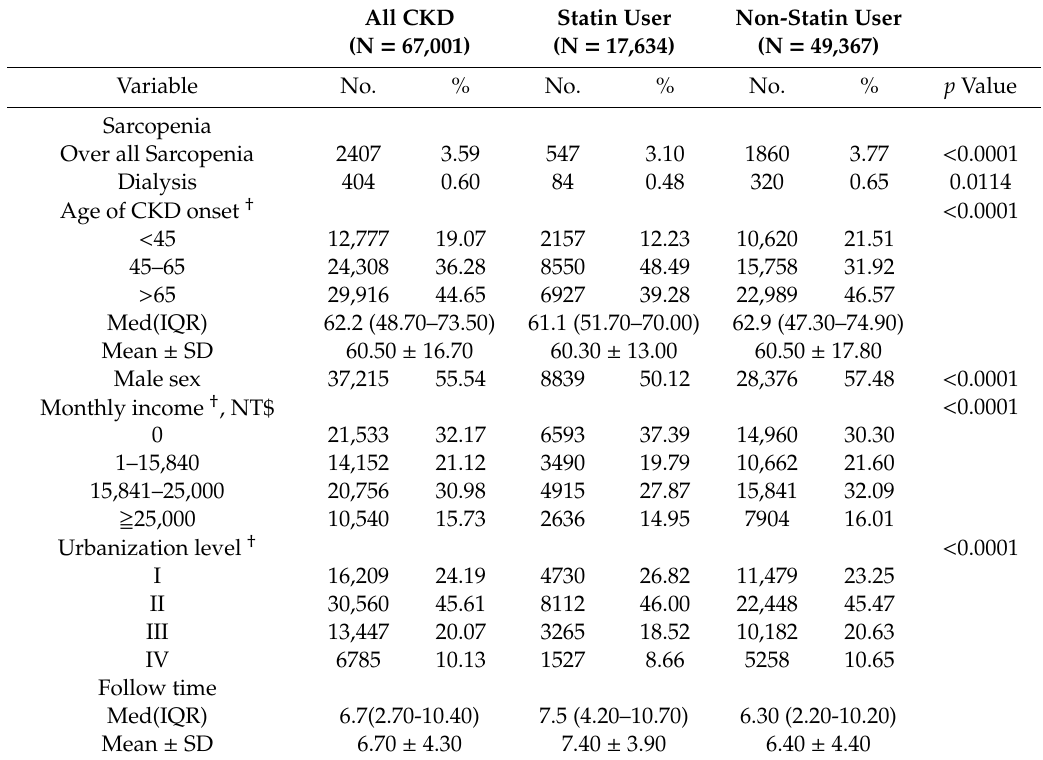
Table 1. Demographic characteristics distribution regarding statins use of a chronic kidney disease population in Taiwan.